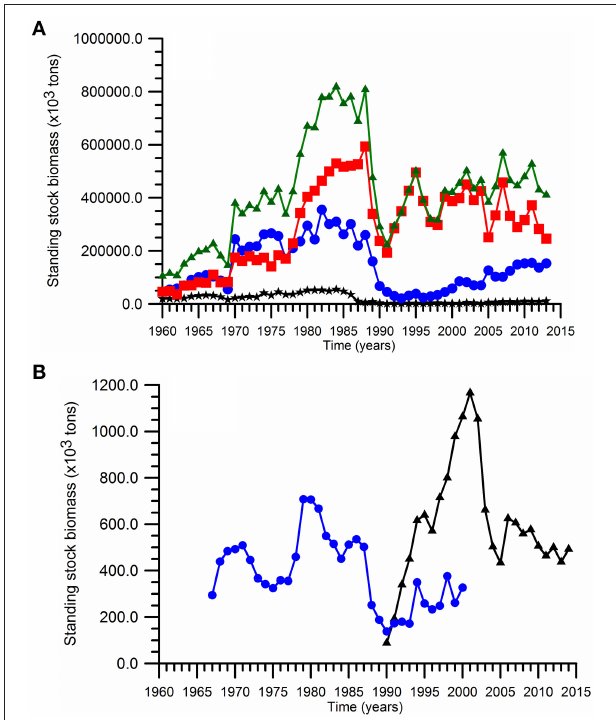
FIGURE 3 | Time series of (A) the annual landings over the entire basin ( N ), the Turkish waters ( (cid:4) ) (the southern sector of of the Black Sea), and Bulgarian and Romanian waters ( * ) (the western sector), Georgia + Russia + Ukraine waters ( · ) (the northern + eastern sector), and (B) of the annual anchovy spawning stock biomass estimated by Shlyakhov and Daskalov (2009) ( · ) and by STECF (2015) ( N